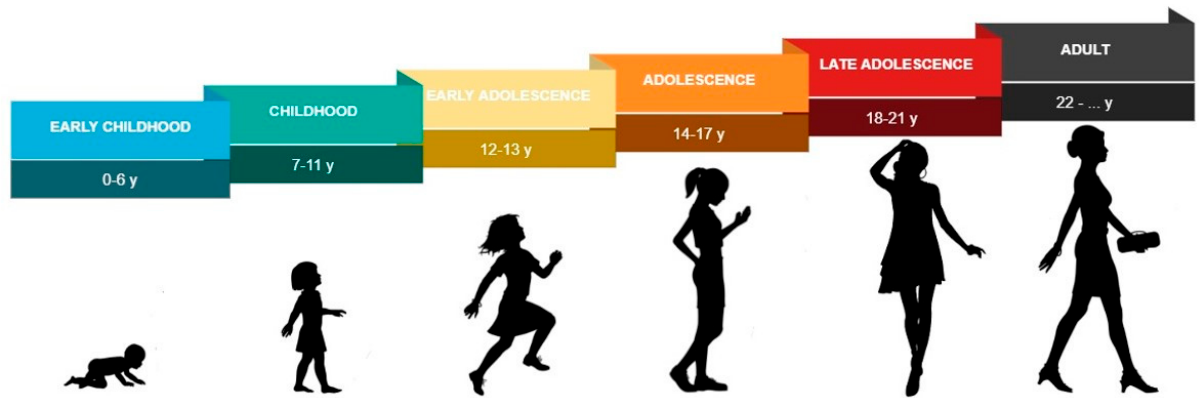
Figure 1. Specific ages for each developmental period (i.e., early childhood, childhood, early adolescence, adolescence, late adolescence, and adulthood) are reported.